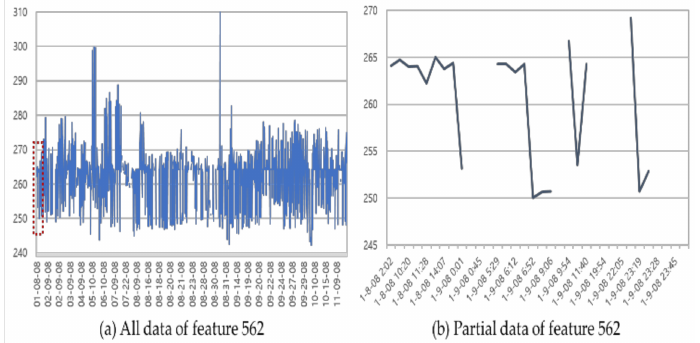
Figure 4. Example of identifying a missing value in the data of feature